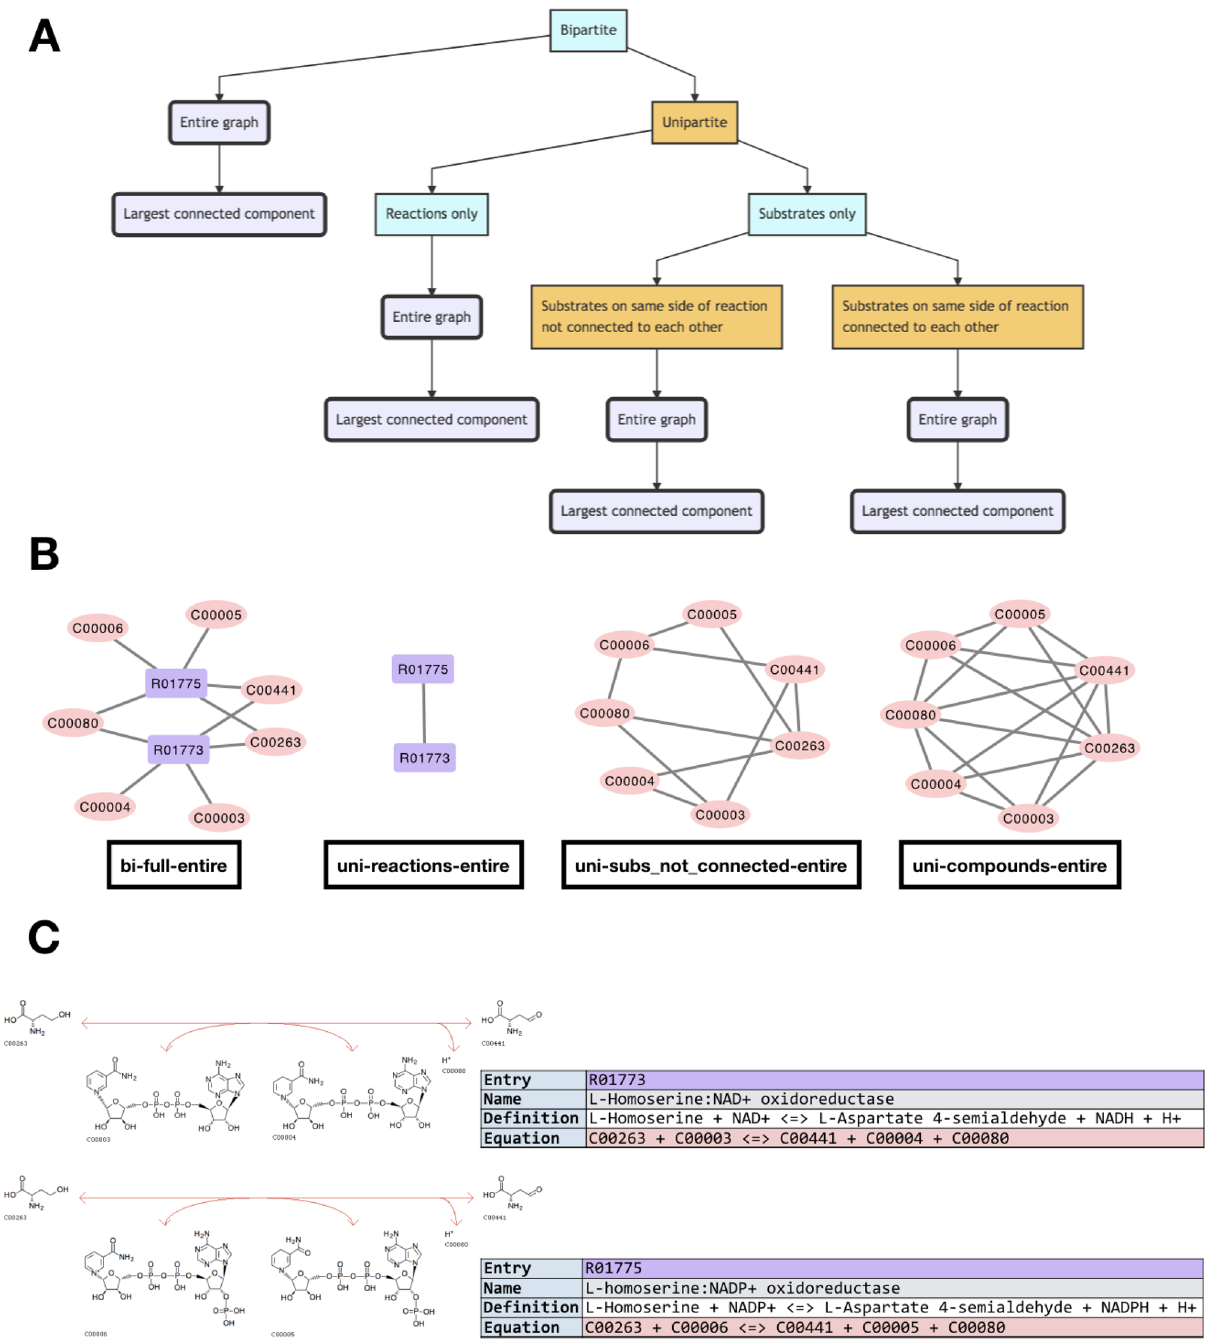
Figure 1. How biochemical datasets are decomposed into network projections. ( A ) Networks are generated from the set of reactions encoded in each genome/metagenome starting from a bipartite representation, and projecting different combinations of attributes. The bold, rounded flowchart nodes show the result of each combination of projections applied in this study. ( B ) The different network projection types of a simple example dataset, composed of two KEGG reactions: R01773 & R01775. The nomenclature used in this paper’s figures is below each network visualization (in this example the entire graph is the same as the largest connected component). ( C ) How the reactions used in the network visualization example above appear in the KEGG database 46–48